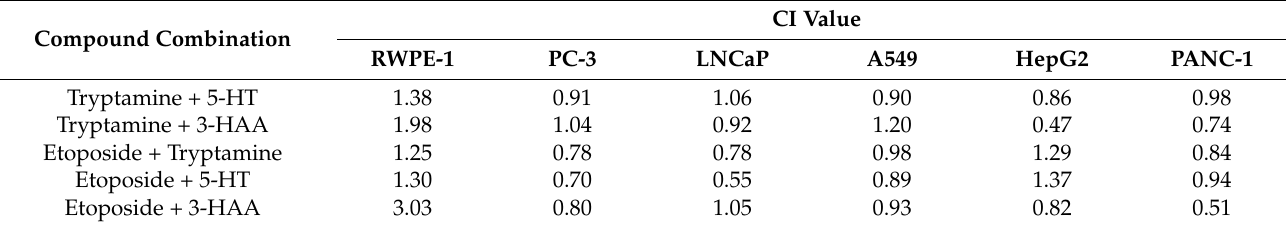
Table 2. CI values of the combined